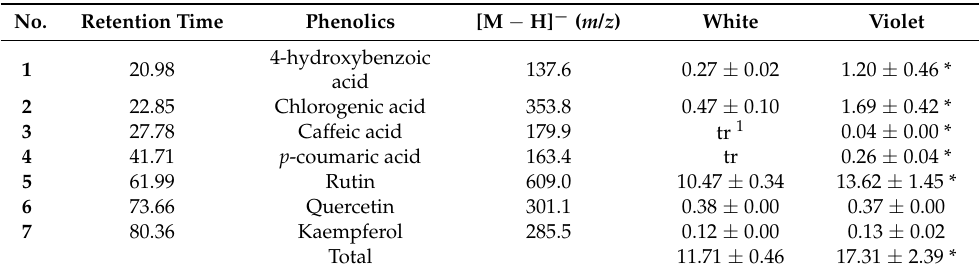
Table 1. Phenylpropanoid contents (mg/g dry wt.) of white flowers of M. denudata and violet flowers of M. liliiflora .